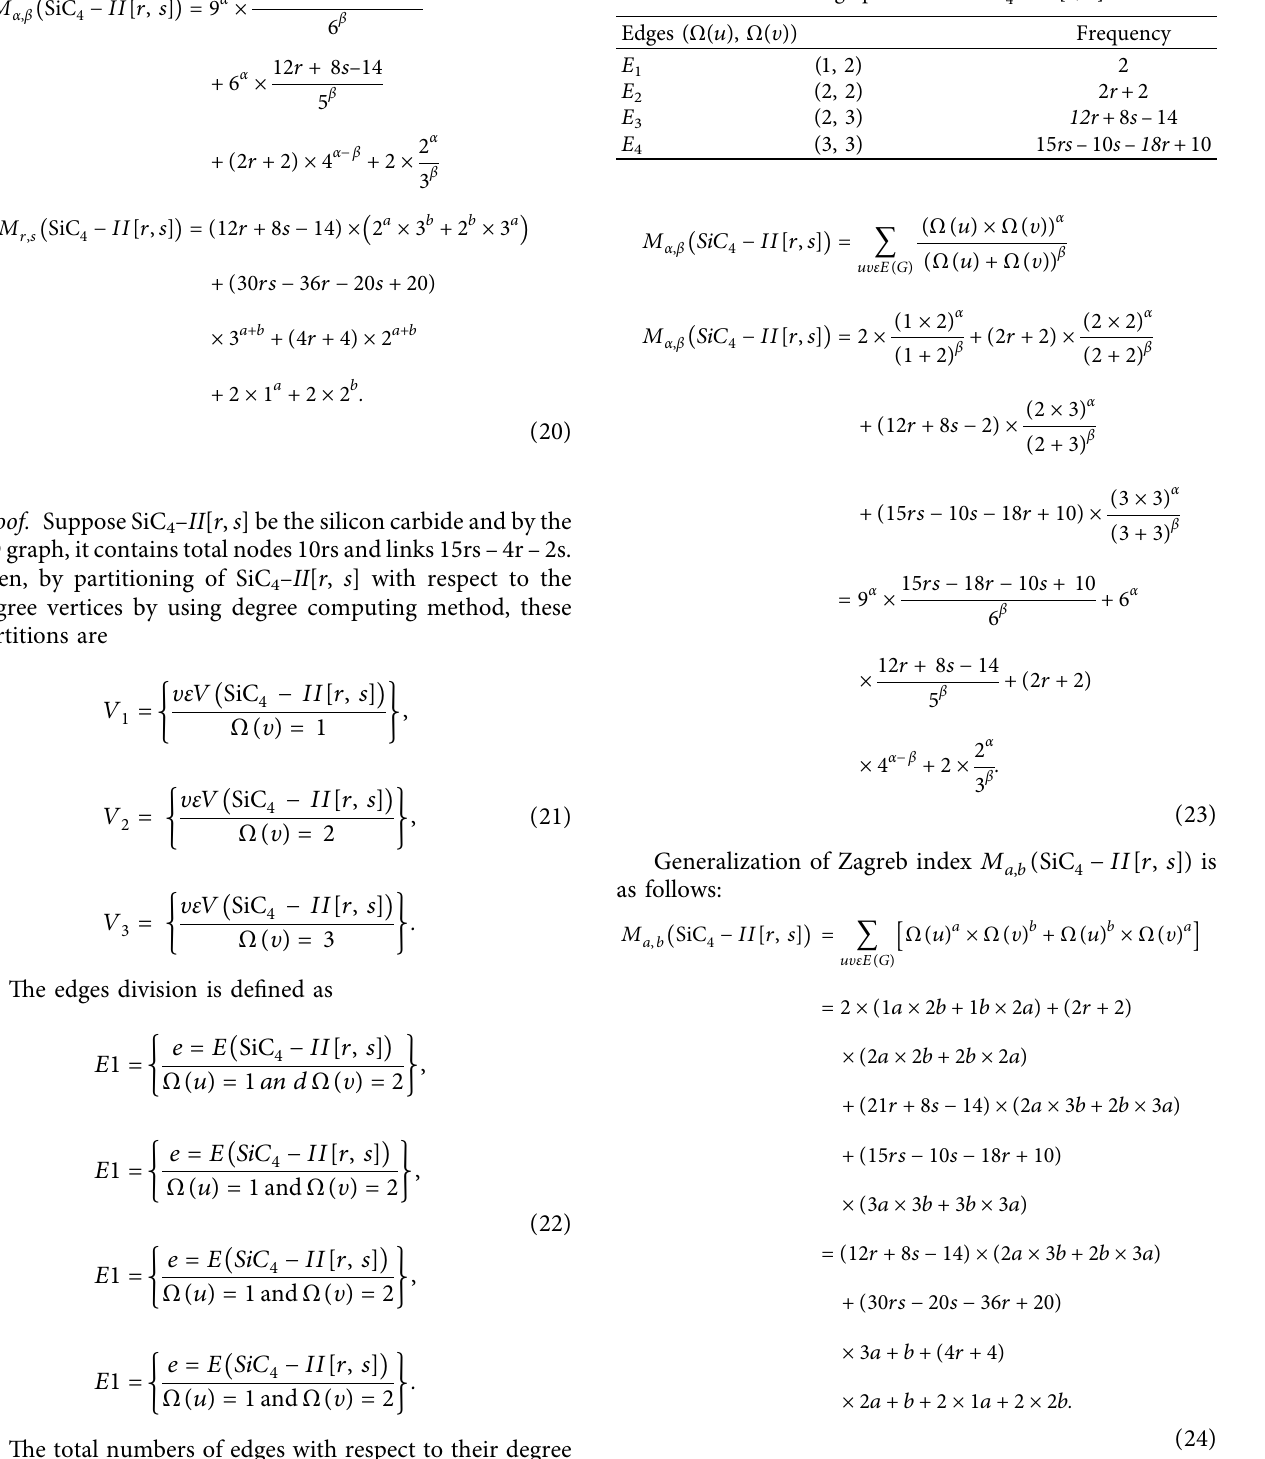
Table 4: Edge partition of SiC